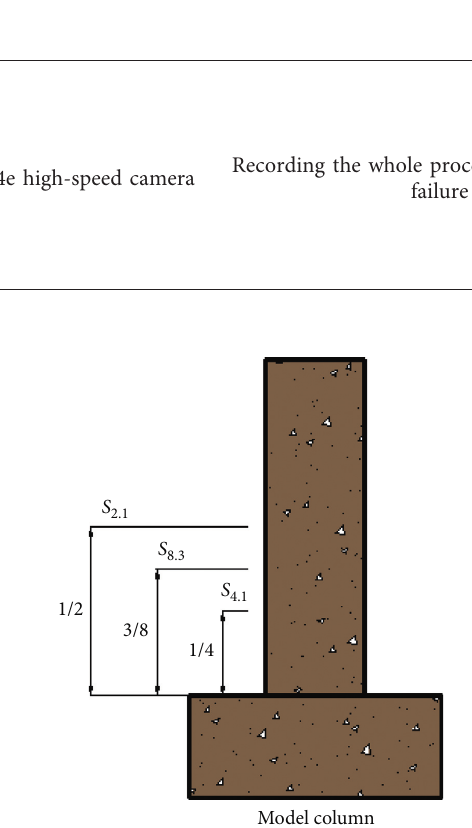
Figure 16: Schematic diagram of model